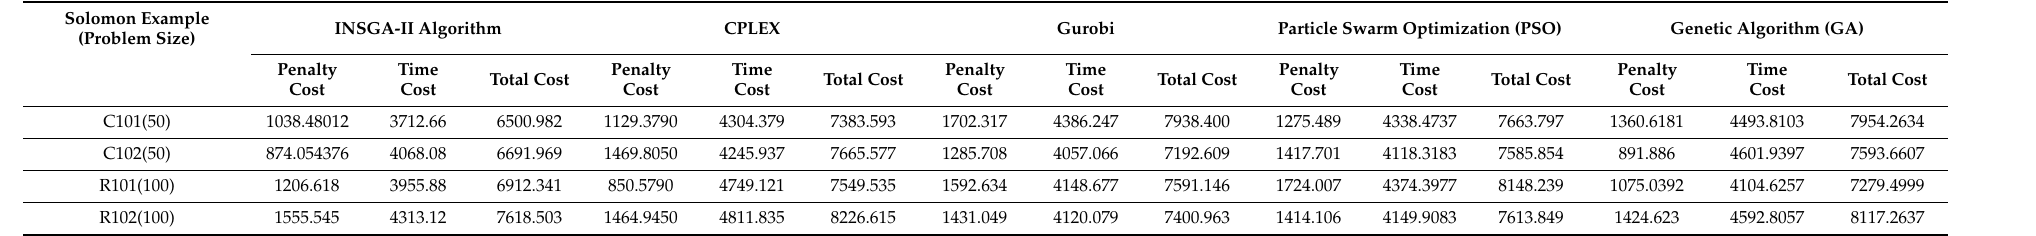
Table 5. Optimization results of different